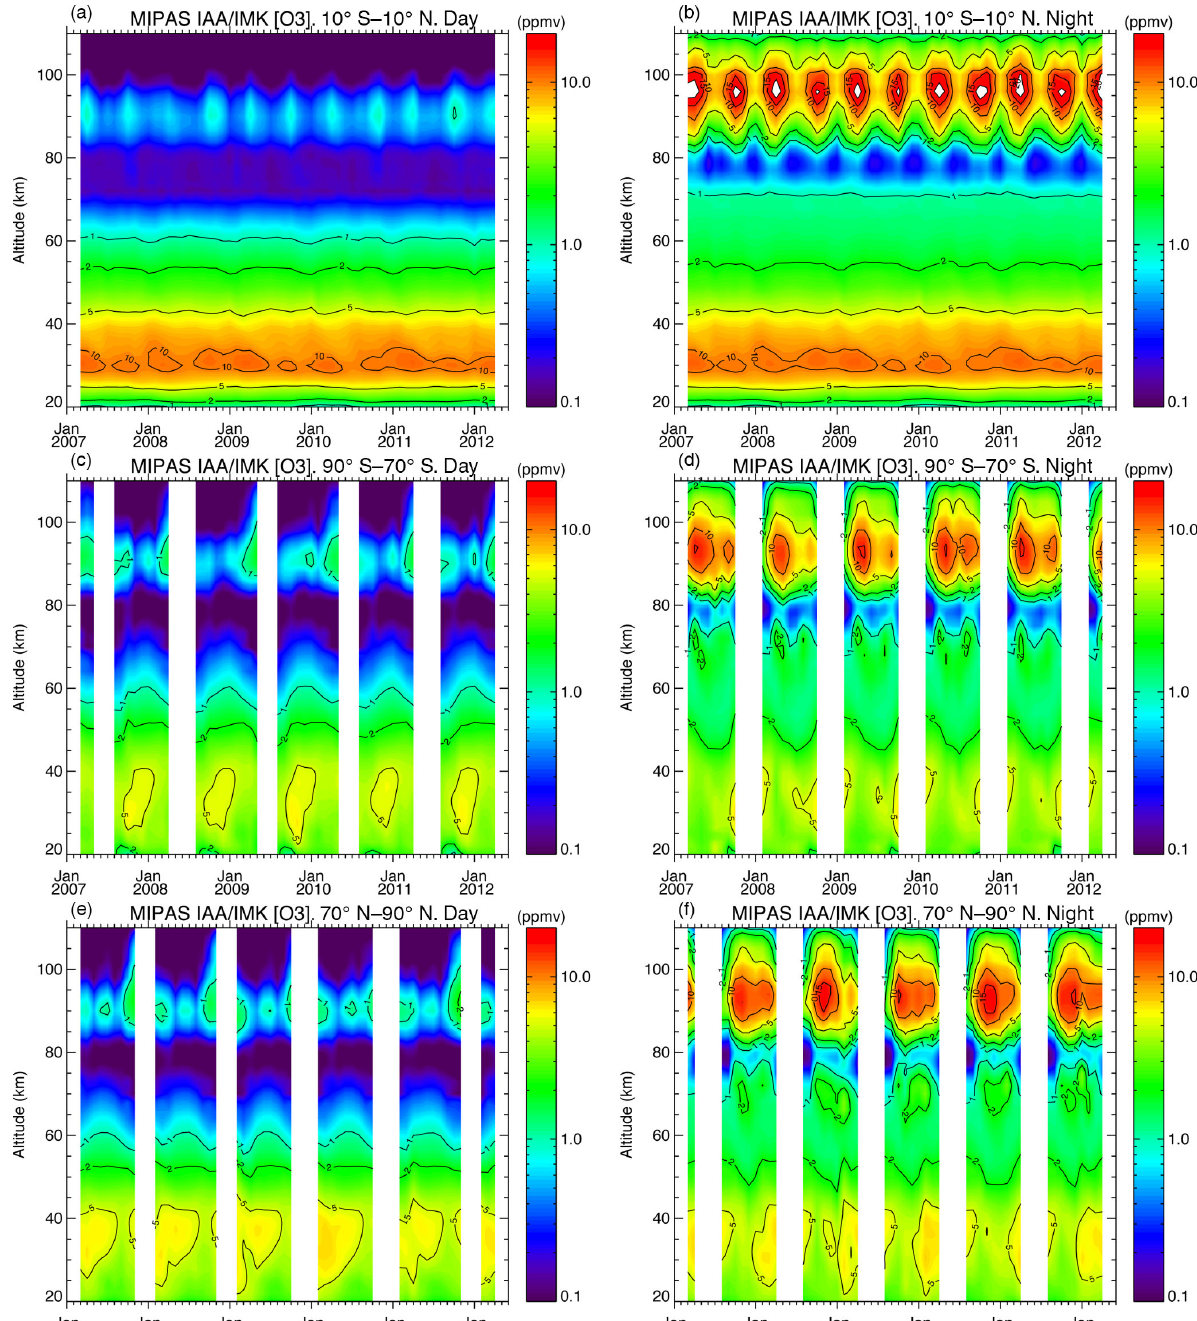
Figure 15. Altitude-resolved series for latitudes near the Equator (10 ◦ S–10 ◦ N) (a, b) , the southern polar region (70–90 ◦ S) (c, d) , and the northern polar region (70–90 ◦ N) (e, f) , for daytime (left column) and nighttime (right